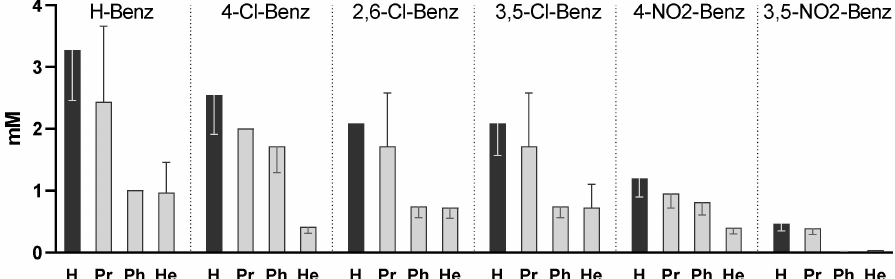
Figure 1. MIC of the free acids and the esters against M. tuberculosis (6 series of compounds). Each series has a different electron withdrawing substituent in the benzoyl group (-H, -4-Cl, -2,6-Cl, -3,5-Cl, -4-NO 2 , and -3,5-NO 2 ) and is composed of a free acid (H) and three esters: propyl (Pr), phenyl (Ph), and hexyl (He). Data represent the median of 3 independent experiments and the error bars depict the interquartile